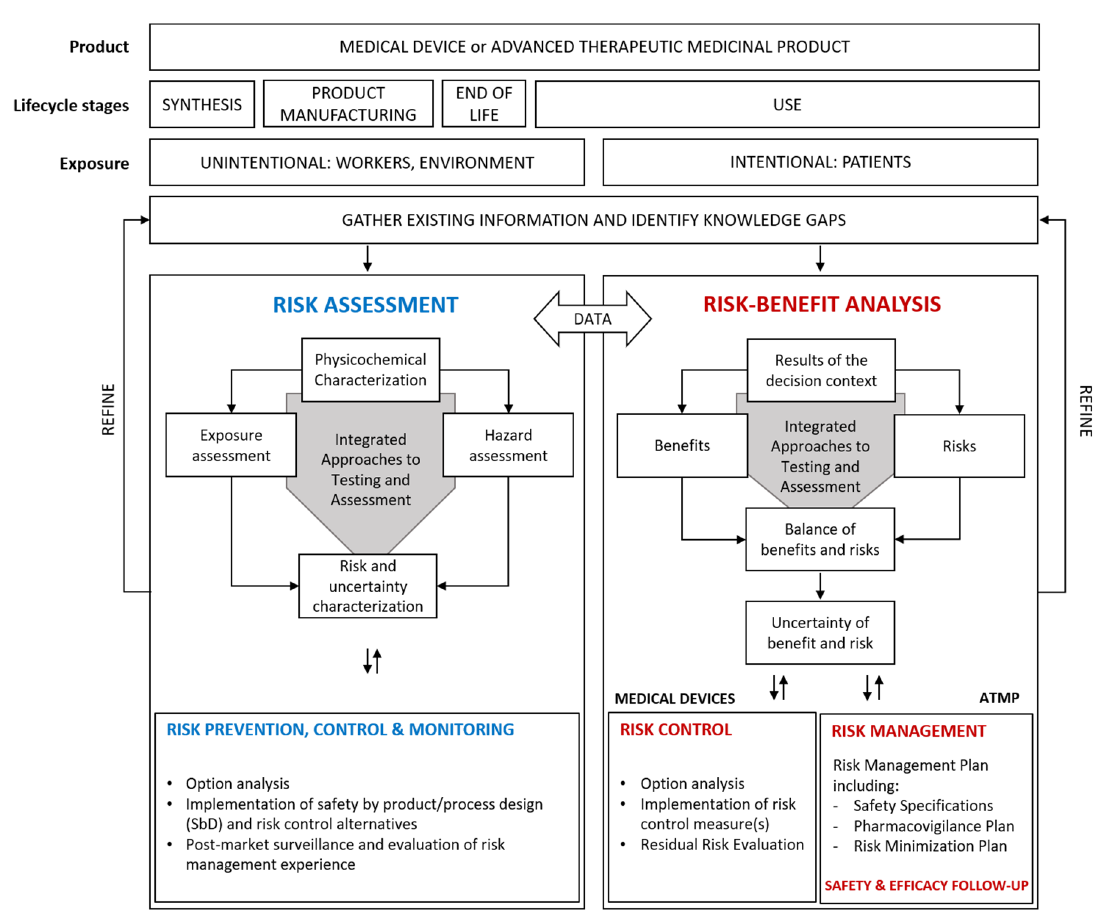
Figure 1. BIORIMA risk management framework for nano-biomaterials (NBMs) used in medical devices (MD) and advanced therapy medicinal products (ATMP).